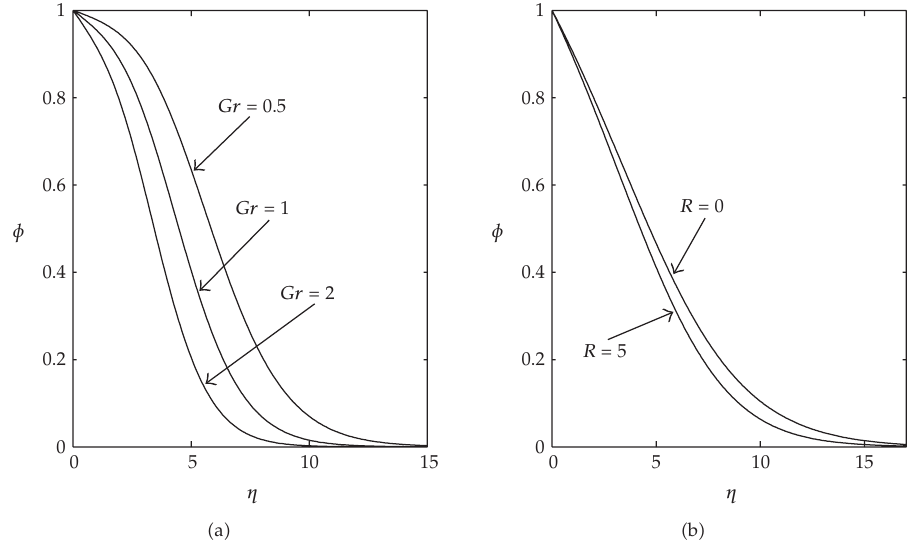
Figure 7: The variation of concentration distribution (cid:8) a (cid:9) with increasing buoyancy numbers with ξ (cid:7) 5 , Pr (cid:7) 0 . 72 , Sc (cid:7) 1 , V 0 (cid:7) 0 . 1 , R (cid:7) 1 and (cid:8) b (cid:9) with increasing radiation parameter numbers with ξ (cid:7) 5 , Gr (cid:7) Gr c (cid:7) 1 , Pr (cid:7) 0 . 72 , Sc (cid:7) 1 , V 0 (cid:7) 0 . 1